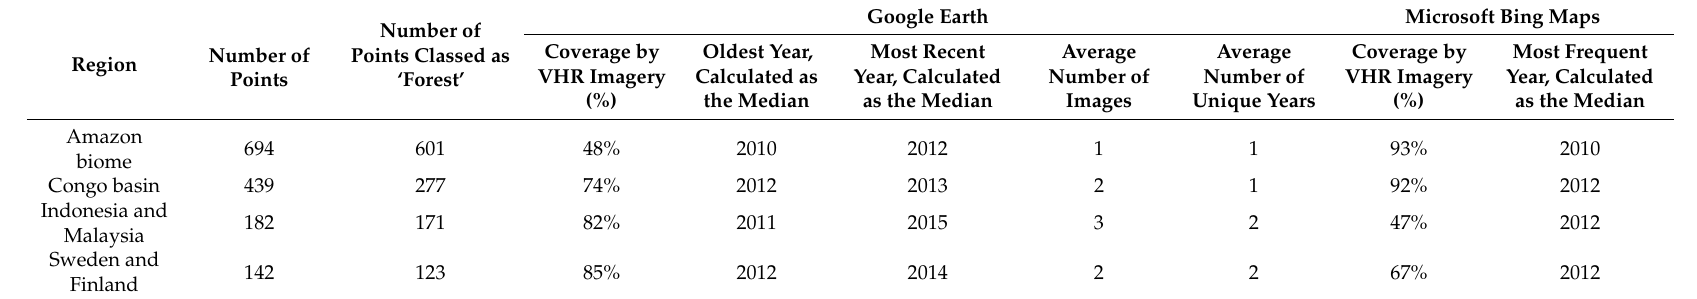
Table 4. Availability of VHR imagery (<5 m) in areas with the highest forest cover change.